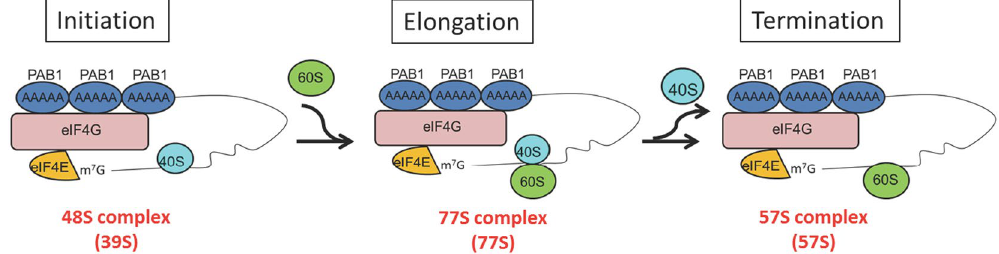
Figure 4. Model for role of 57S complex in translation. A summary is presented of the composition and probable roles of the principal three complexes discussed (39S, 57S, and 77S). The text contains additional models and compositions of these